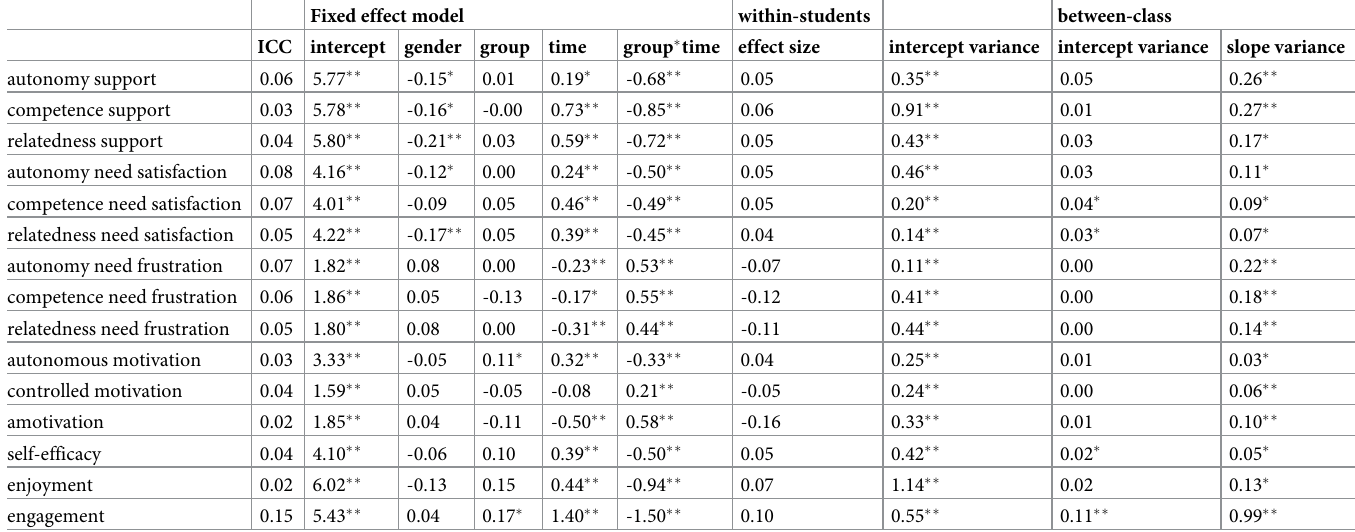
Table 2. Results of mixed repeated measures ANCOVA in all